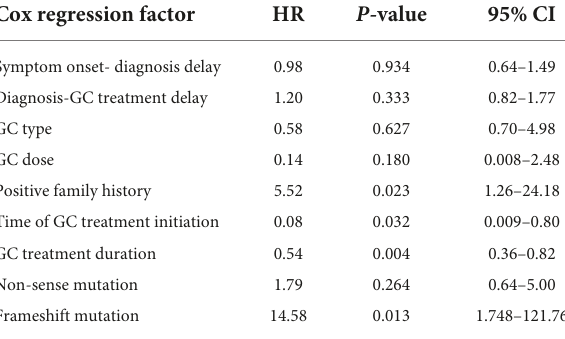
TABLE 3 Multivariate Cox regression analysis of survival time in children with Duchenne muscular dystrophy (DMD) treated with glucocorticoid